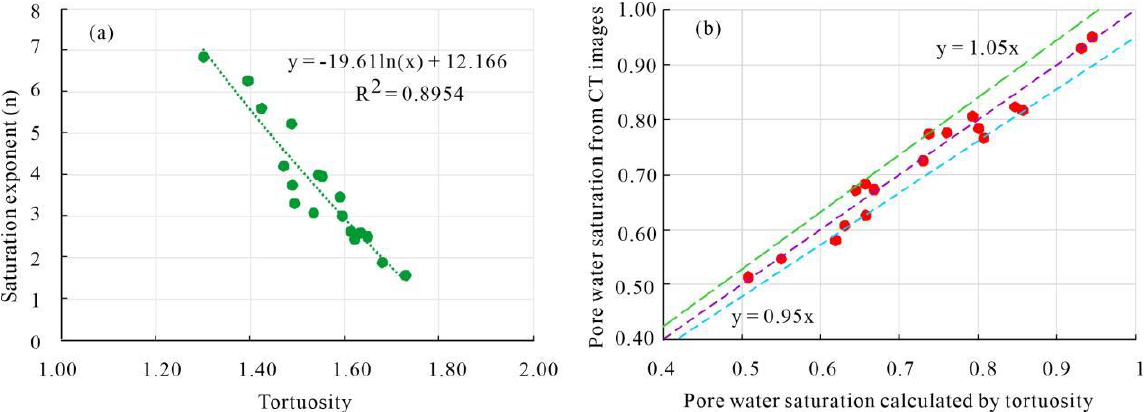
Figure 10. The experimental fitting mode of the saturation exponent and tortuosity in this study ( a ) and the comparison between the pore water saturation calculated by the experimental fitting model and from X-CT images ( b ). The relative errors are almost less than 5%.